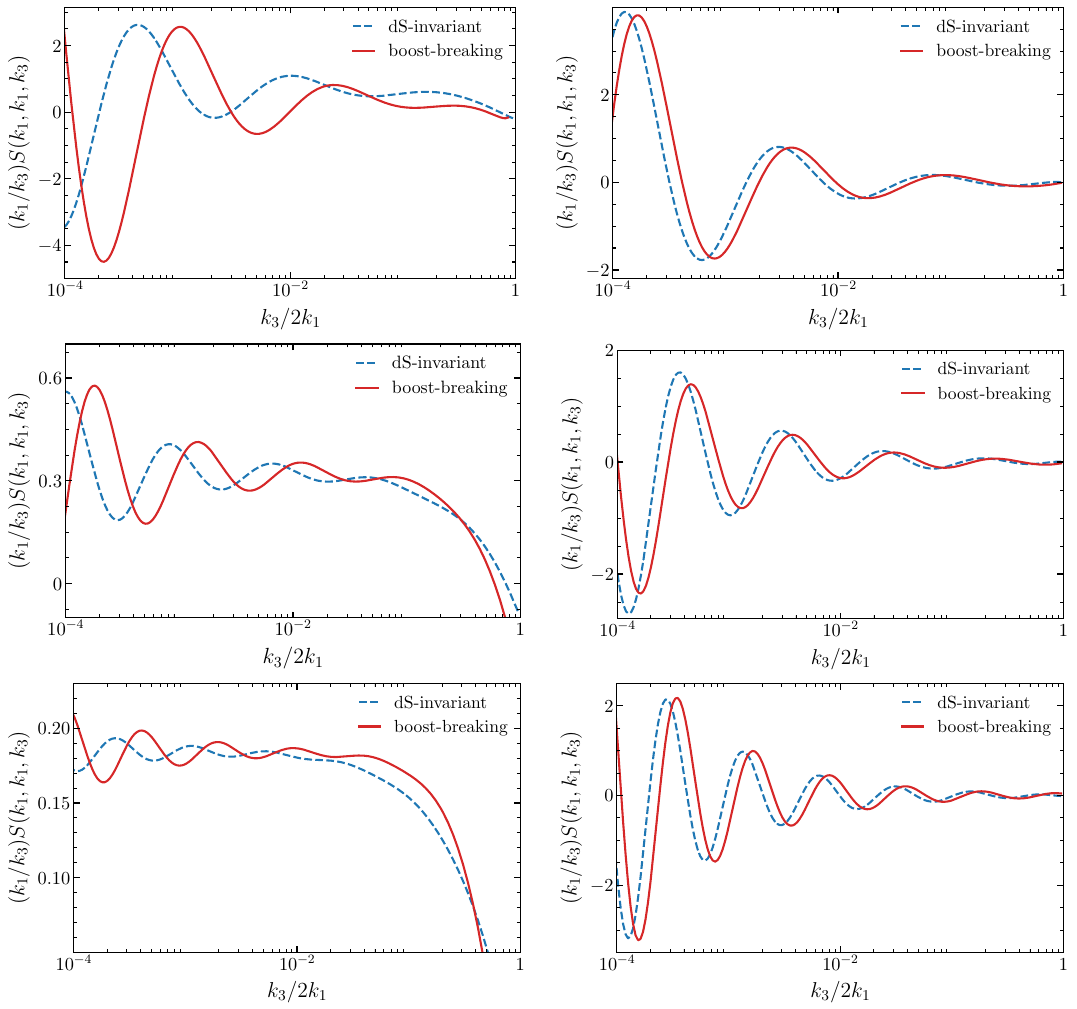
Figure 5 . Shape functions of the cosmological collider bispectra in the isosceles-triangle configuration with k = k and c = 1 . Left panel: shapes from the massive scalar exchanges with µ = 2 (top), 1 2 s /c σ µ = 3 (middle) and µ = 4 (bottom). Right panel: shapes from the massive spin-2 exchanges with µ = 2 (top), µ = 3 (middle) and µ = 4 (bottom). For the boost-breaking results we have chosen one particular combination of interactions for